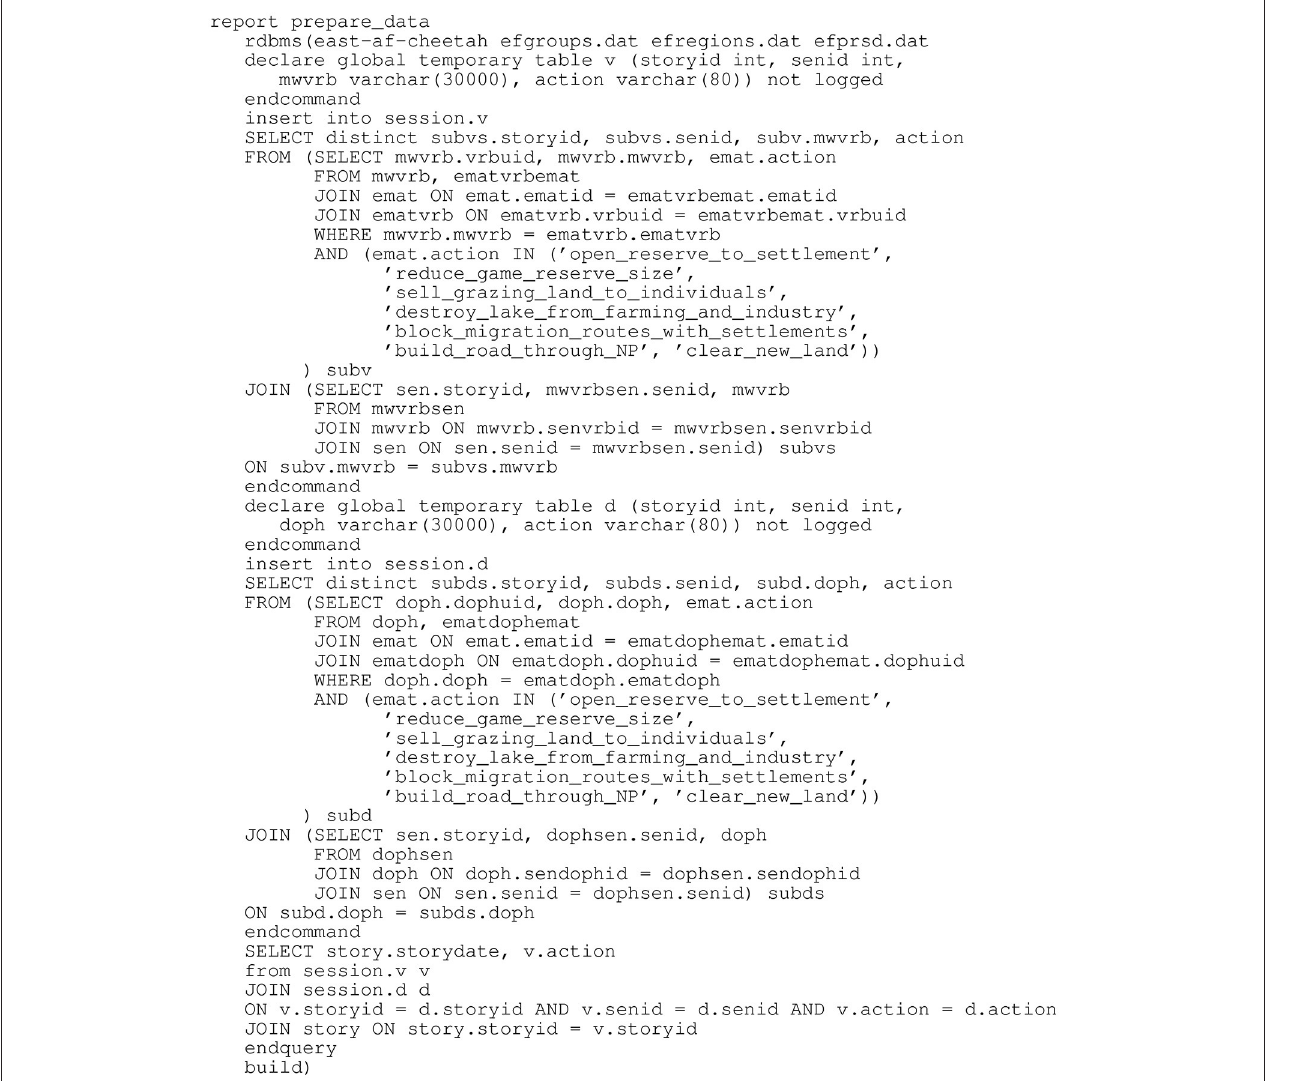
FIGURE 6 | An rdbms_() relation to build temporary tables in the east-af-cheetah EMAT database and then query them for habitat-destroying EMAT